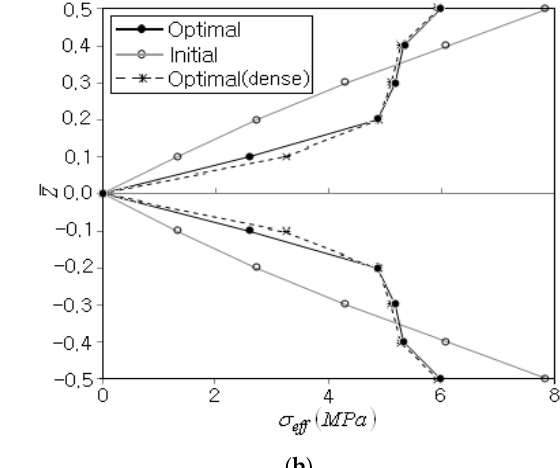
11 of 19 Table 3. Variation of the objective function to the iteration (sym). Iteration